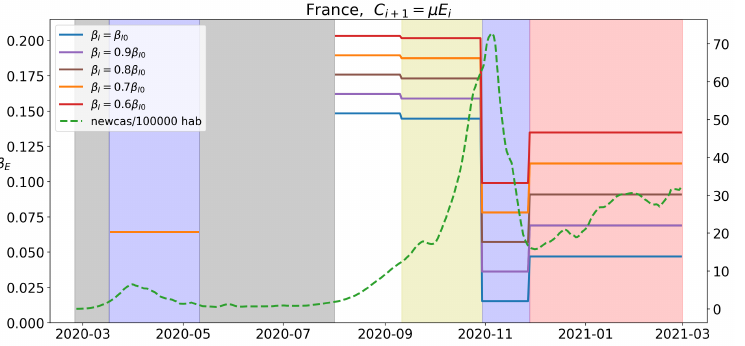
Figure 3. Value of β E for the different levels of lockdown. Blue background will correspond to Stage 1, red to Stage 2, yellow to Stage 3 and white to Stage 4. A green dotted line corresponds to the value of new cases per 100,000